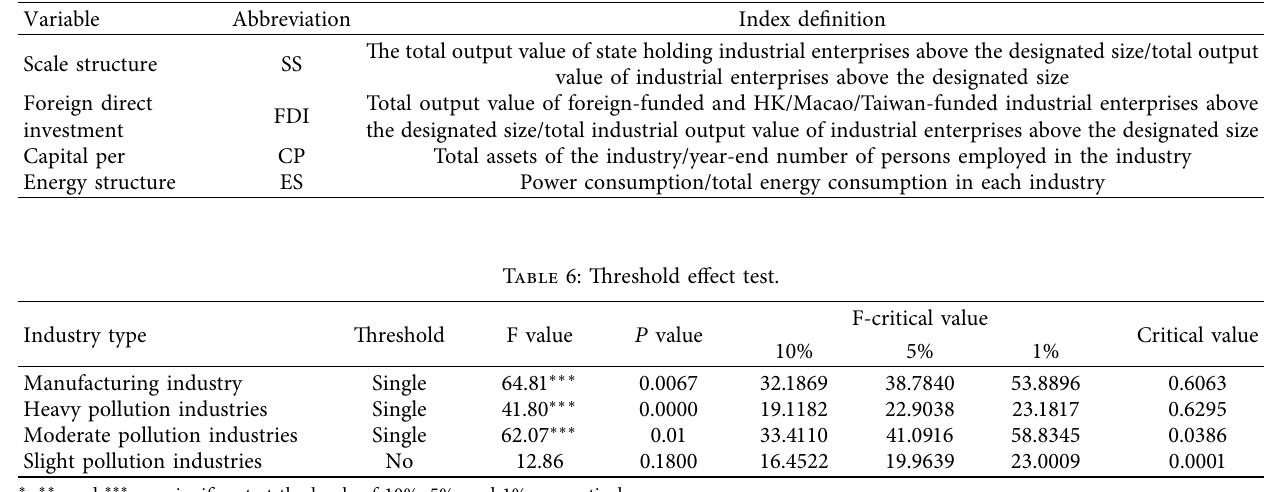
Table 5: Explanatory variable selection and definitions.